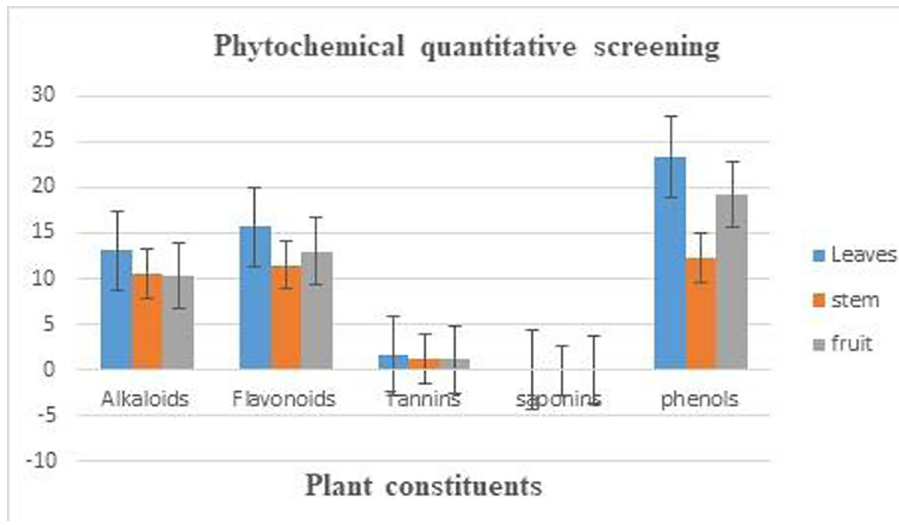
Fig 1. Graphical representation of phytochemical quantitative analysis of leaf, stem and fruit of Emex spinosa .